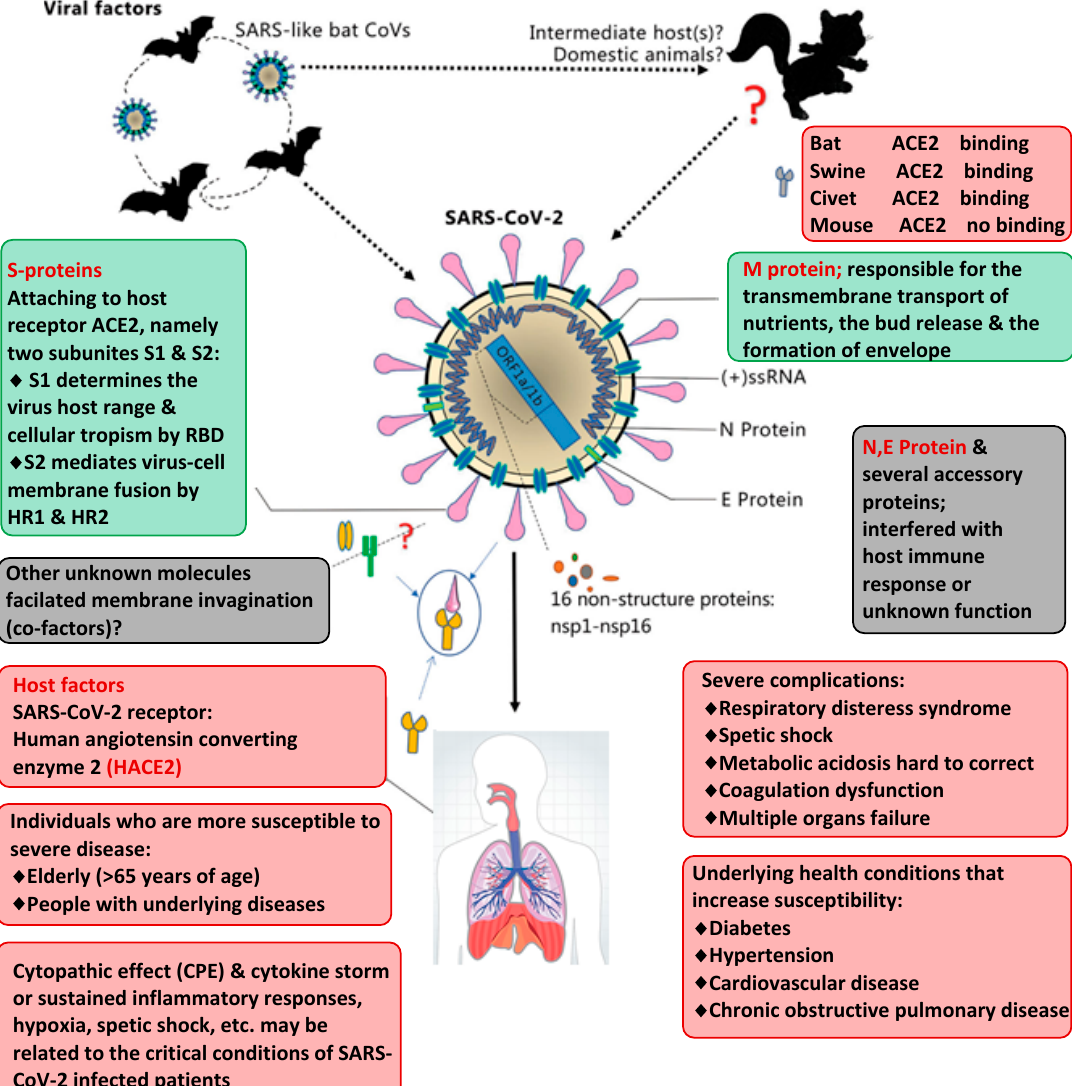
Figure 5. Viral, genetic or host factors that influence the SARS-CoV-2 pathogenesis and / or epidemiology, and a summary of the sway of susceptible host factors to infection and disease progression. HR1 and HR2: heptad repeats 1 and 2. Reproduced with permission from Ref. [4]. An Open Access article (CC BY 4.0).